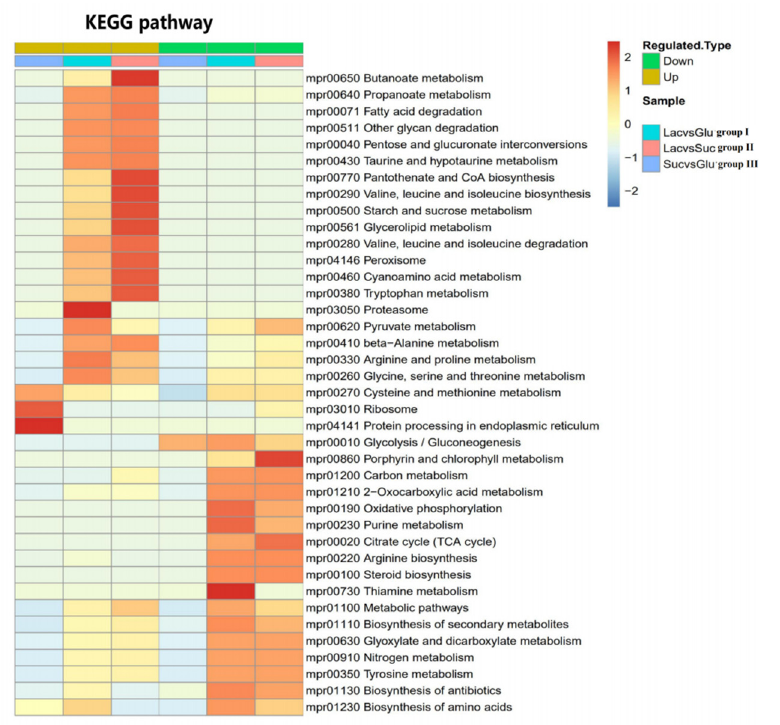
Figure 7. Cluster analysis heat map based on the enrichment of the Kyoto Encyclopedia of Genes and Genomes (KEGG) pathway.